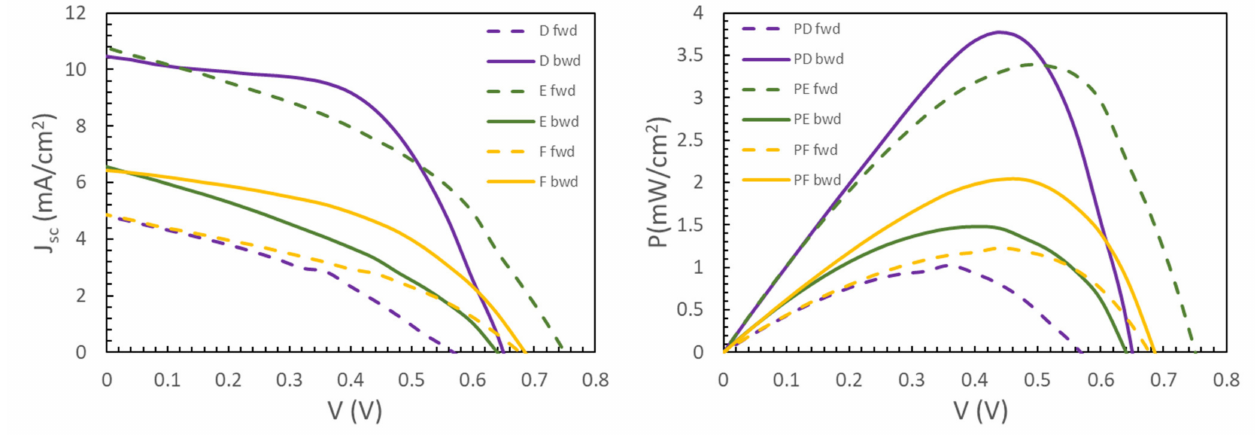
Figure 3. Current-voltage (I–V) (left) and power-voltage (P–V) (right) curves of the best MAPI perovskite solar cell with 4-aminobenzoic acid (PABA) (D), terephtalic acid (TPA) (E) and 3-phosphonopropionic acid (H3PP) (F) additives, all of them showing hysteresis between the forward (slashed line) and backward (continuous lines) sweep. All backward sweeps showed better performance, except the E cell, which was better in forward